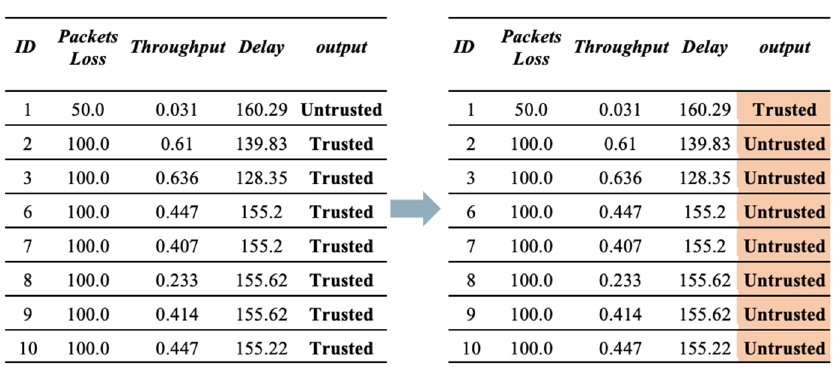
Figure 6. Sample of dataset before and after applying good-mouthing and bad-mouthing a tt acks.